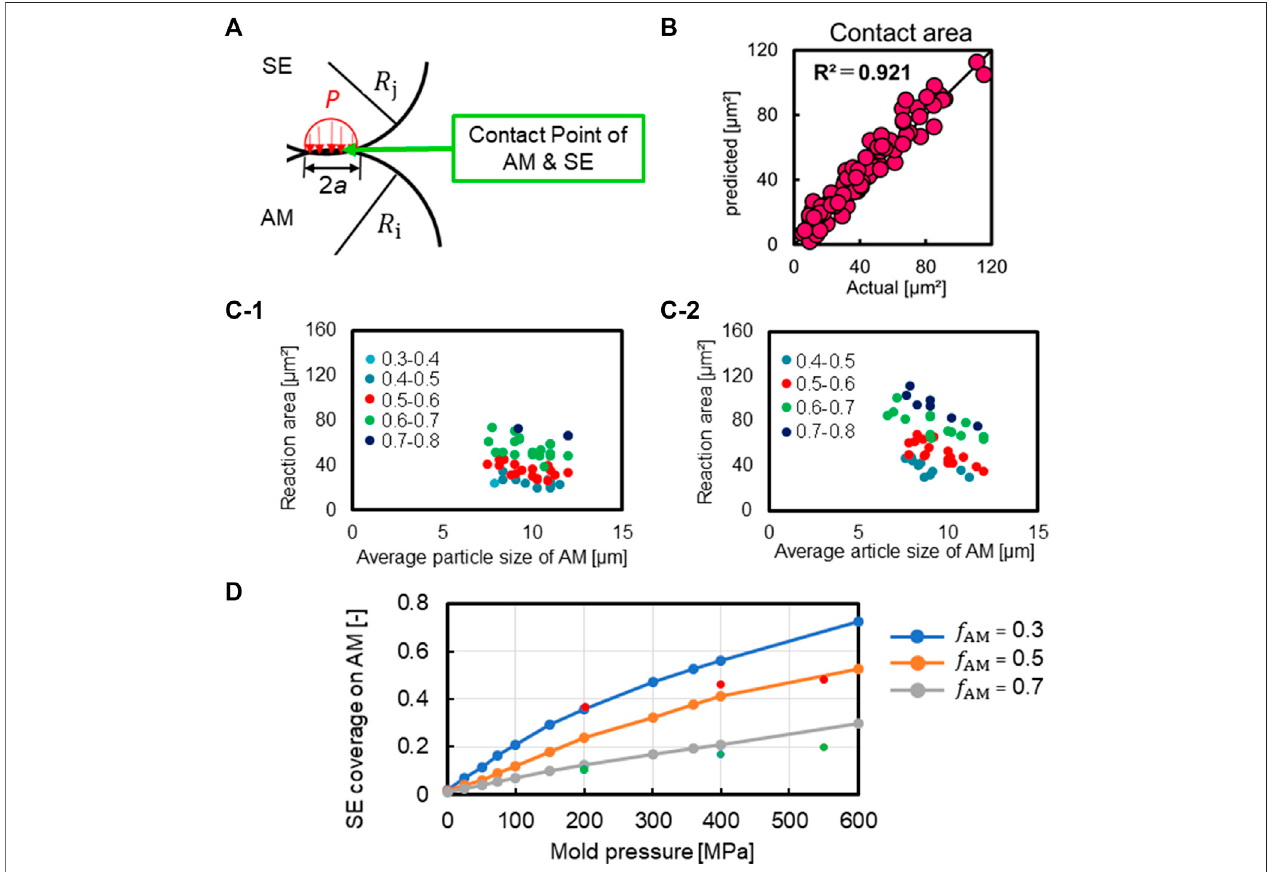
FIGURE 5 | (A) Hertz ’ s contact theory and predicted contact area results. (B) Comparison between contact area predicted by CNN and calculated by DEM and Hertziancontacttheory,indicatingconsistencybetweenthepredictions. (C-1,C-2) Relationshipbetweenparticlesizeandreactionboundaryareaforeachcompression ratio and CNN results. (C-1) has a smaller compression ratio than (C-2) , and the color coding of the dots on the graph is based on the volume fraction of AM. (D) Comparison with previously reported literature values. Here, f AM is volume fraction of AM Red circle represents f AM (cid:1) 0 . 5%, green circle represents f AM (cid:1) 0 .